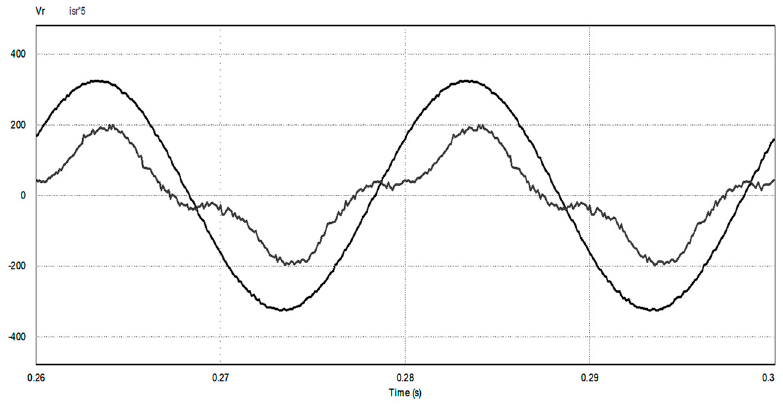
Figure 12. Case B—voltage and current on phase R . Figure 12. Case B - voltage and current on phase R . Figure 12. Case B - voltage and current on phase R .